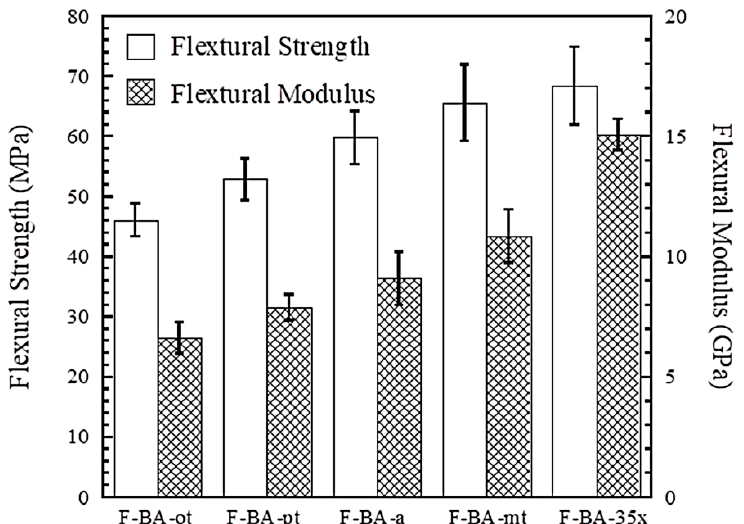
Figure 4. Flexural property of polybenzoxazine composites prepared from different benzoxazine resins.